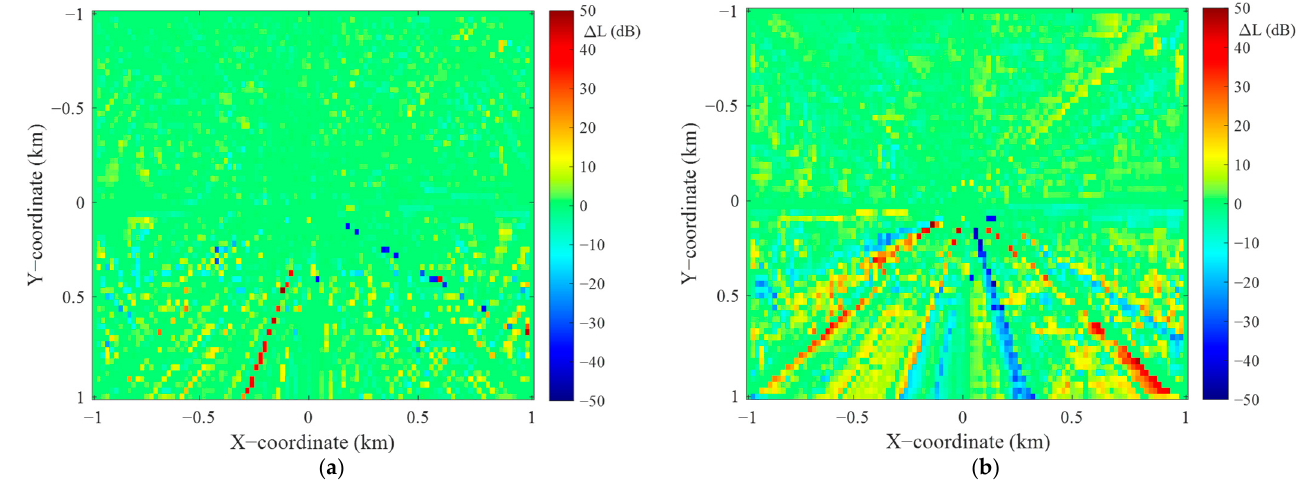
( ) CDF Δ , L which are depicted in Figure 14b. Figure 13. Error maps for selected angular resolutions ( a ) Δα = 2° and ( b ) Δα = 10°. Figure 13. Error maps for selected angular resolutions ( a ) ∆ α = 2 ◦ and ( b ) ∆ α = 10 ◦ . ( ) CDF Δ , L and root-mean-square error (RMSE),